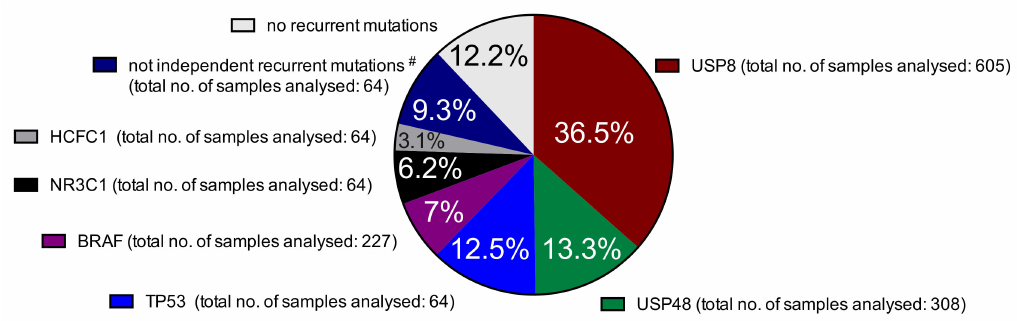
Figure 1. Incidence of all published recurrent somatic mutations associated with Cushing’s